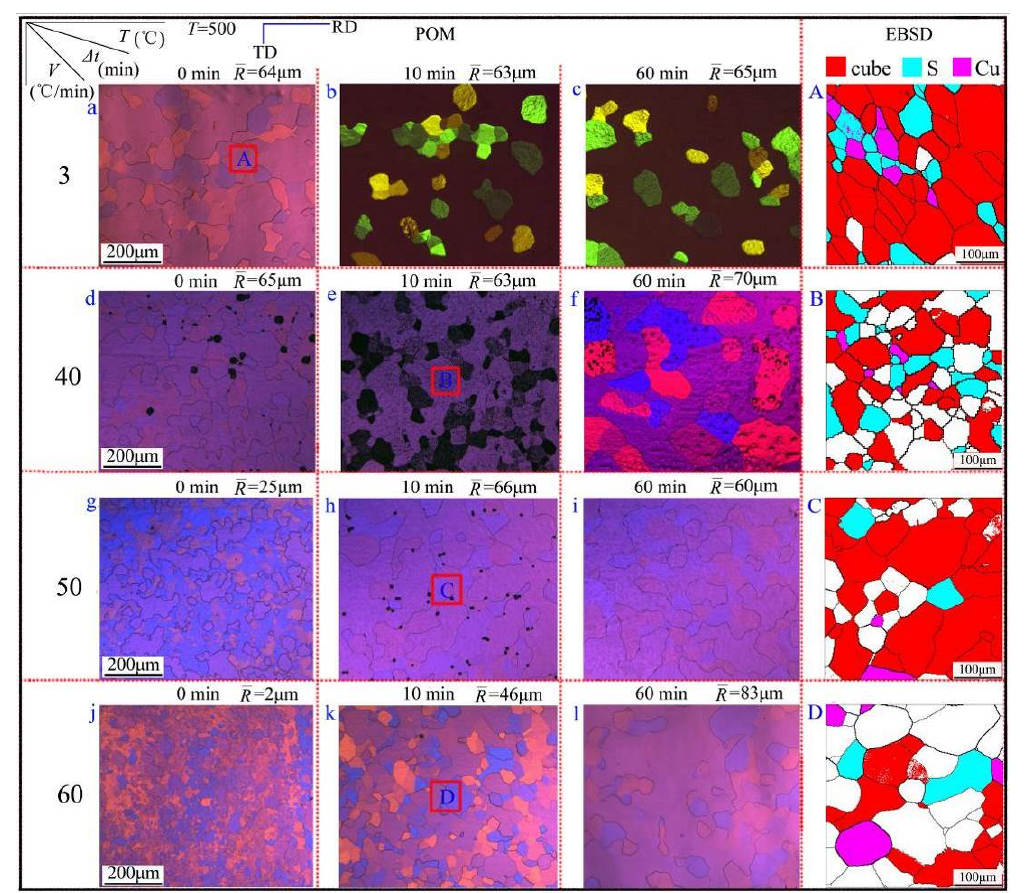
Figure 4. Microstructures of aluminum foil during the annealing process with different heating rates ( a – l ) polarized microstructures; (A–D) EBSD maps corresponding to ( a – l ).